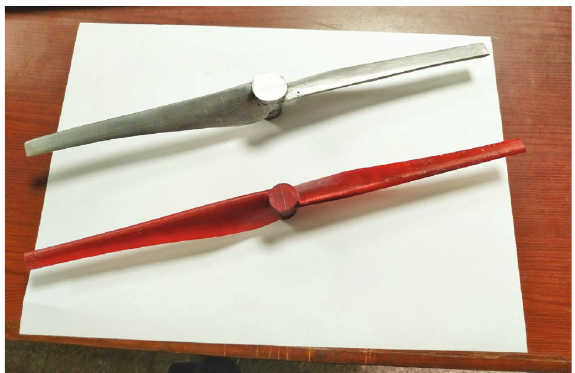
Figure 18: Thrust test bed. Table 3: Thrust rating obtained experimentally.